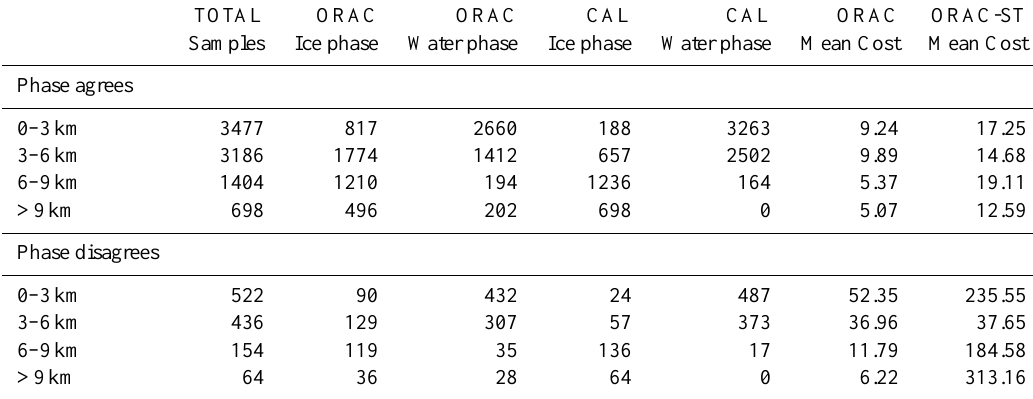
Table 1. Comparison of ORAC and ORAC + stereo phase retrievals counts against collocated CALIOP samples for single-layer clouds over water (determined by CALIOP and AMSR-E, respectively). In the “phase agrees” rows, both ORAC and ORAC + stereo retrieve the same phase. In the “phase disagrees” rows ORAC and ORAC + stereo retrieve opposite phases. For example taking the entries for 0–3km for phase disagrees: ORAC retrieves 90 samples with ice phase and ORAC + stereo retrieves 90 samples with water phase; ORAC retrieves 432 samples with water phase and ORAC + stereo 432 samples with ice phase.